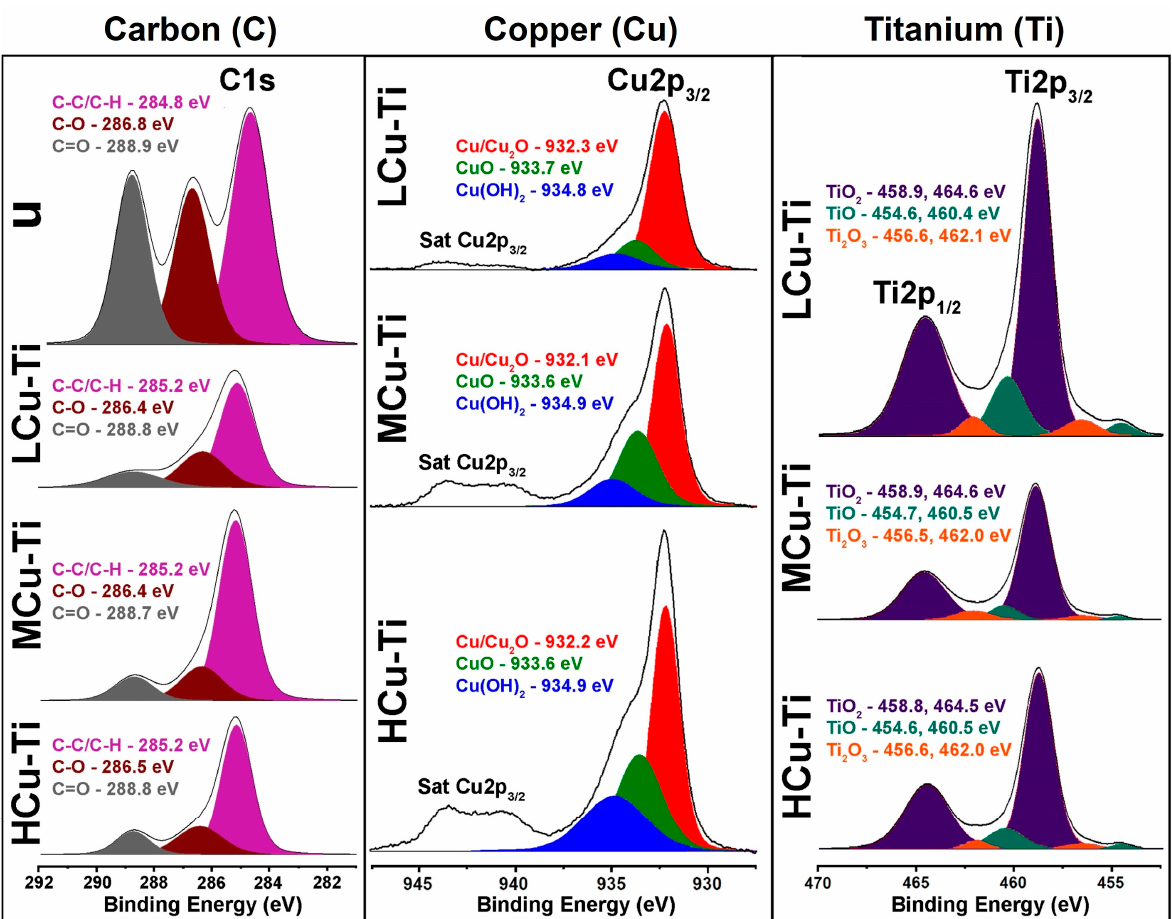
Figure 3. C1s, Cu2p3/2 and Ti2p XPS core spectra of unmodified (u) and surface-modified PLGA scaffold samples (LCu-Ti, MCu-Ti, HCu-Ti). Note: The unmodified PLGA scaffolds (u) contains no Cu and Ti and thus the XPS spectra shows no Cu2p 3/2 and Ti2p 3/2 peaks, because of not being surface-modified by co-sputtering of Cu and